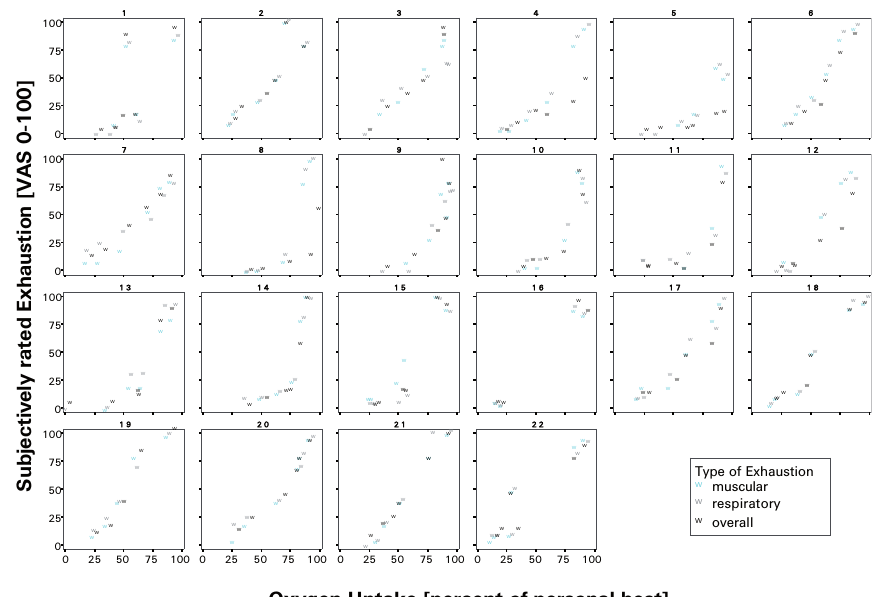
Figure 5 Relationship between the estimated time to exhaustion and peak oxygen uptake [per- cent personal best] in 22 healthy control subjects. Each panel represents the results of an individual test person. Although clear rank correla- tions existed within subjects there was a relatively large interindividual variability.